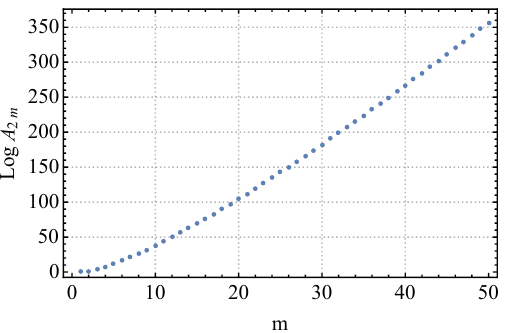
Figure 1 . Plot showing the value of the parameter log A 2 m